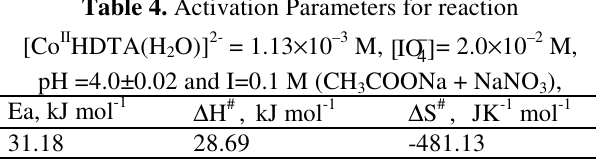
Table 4. Activation Parameters for